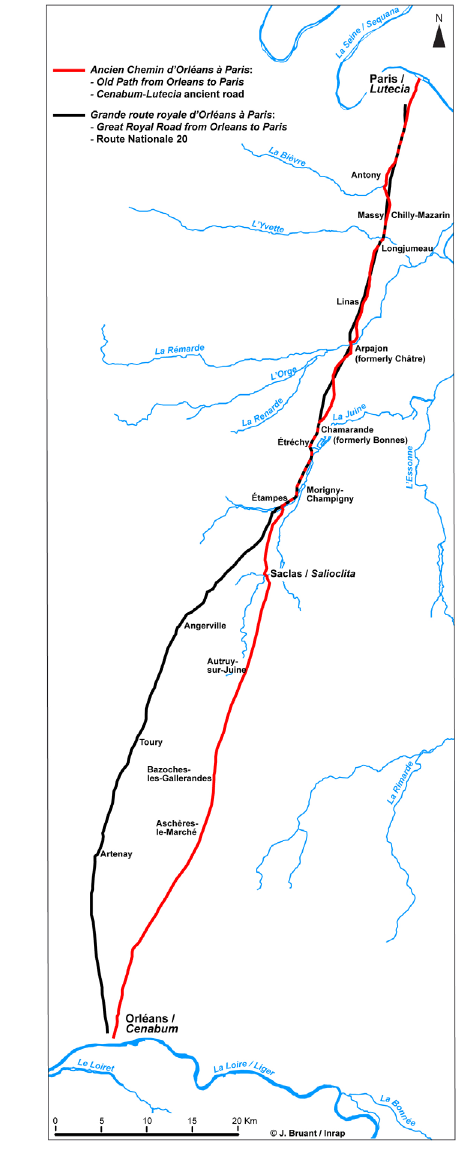
Figure 3. The Old Path from Orleans to Paris ( Ancien Chemin d’Orléans à Paris / Cenabum-Lutecia ancient road) replaced during the Modern period by the Great royal road ( Grande route royale d’Orléans à Paris ). © J.